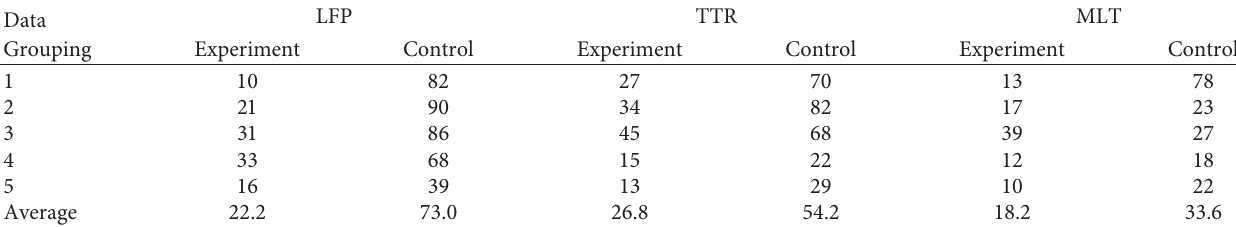
Table 4: Variation data on the development of oral English of EFL learners.